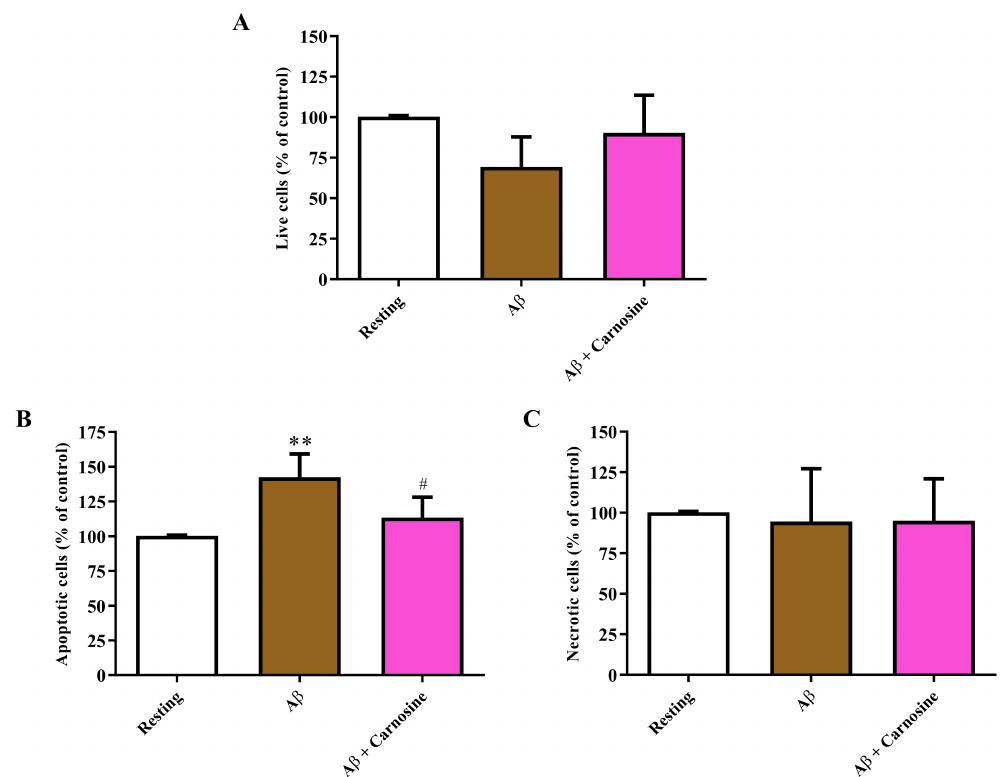
Figure 2. Change in the percentage (%) of ( A ) live cells, ( B ) apoptotic cells, and ( C ) necrotic cells caused by challenging RAW 264.7 cells with A β 1-42 oligomers and protective effects of carnosine. RAW 264.7 cells were treated for 24 h with A β 1-42 oligomers (2 µ M) in the absence or presence of carnosine (20 mM; 1 h pre-treatment). Data are the mean of 3 independent experiments and are expressed as the percent variation with respect to the number of apoptotic or necrotic cells recorded in resting (control) conditions. Standard deviations are represented by vertical bars. ** significantly different from resting cells, p < 0.01; # significantly different from A β 1-42 oligomer-treated cells, p < 0.05.